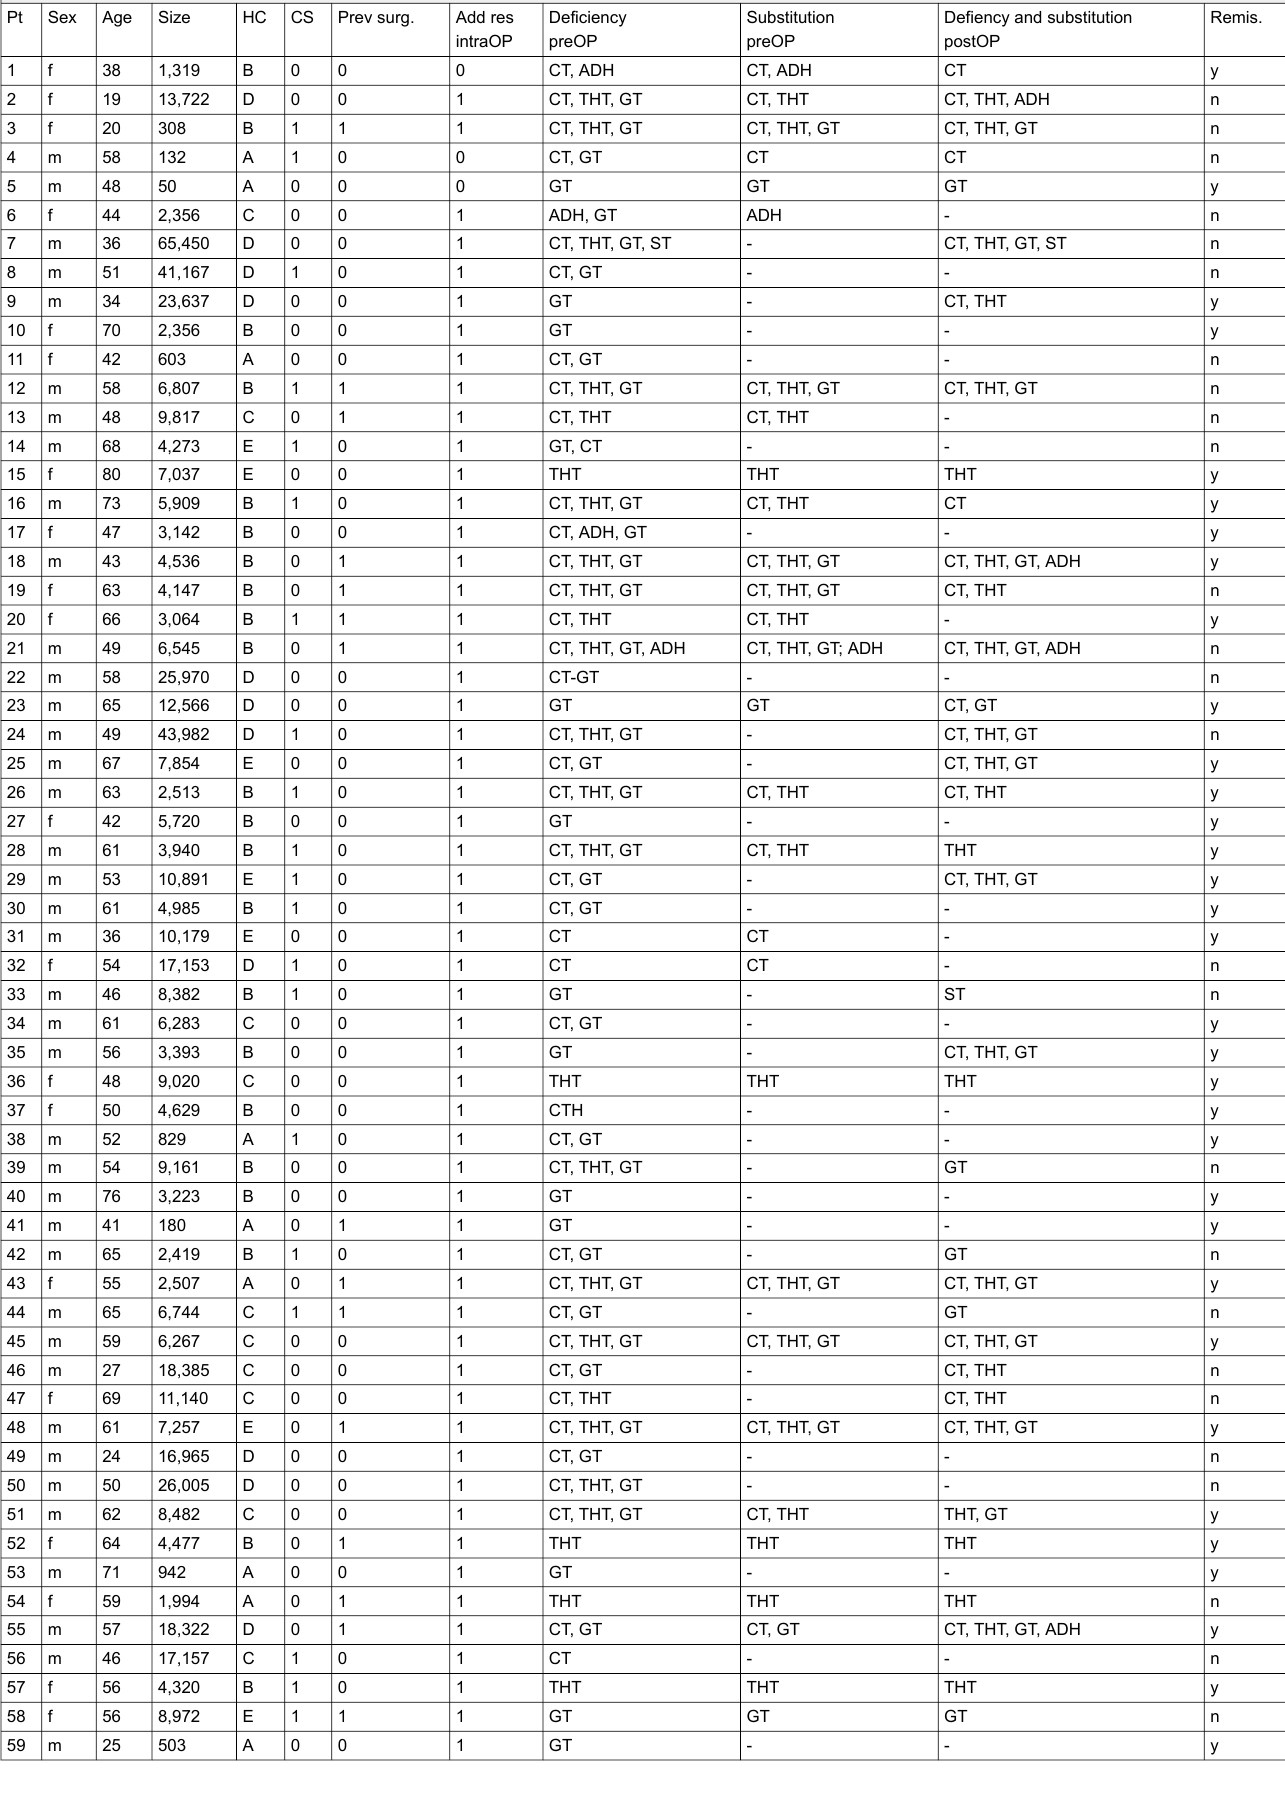
Table 3: Characteristics of 62 patients with preoperative hypopituitarism: type of deficiencies and replacement therapy before and after